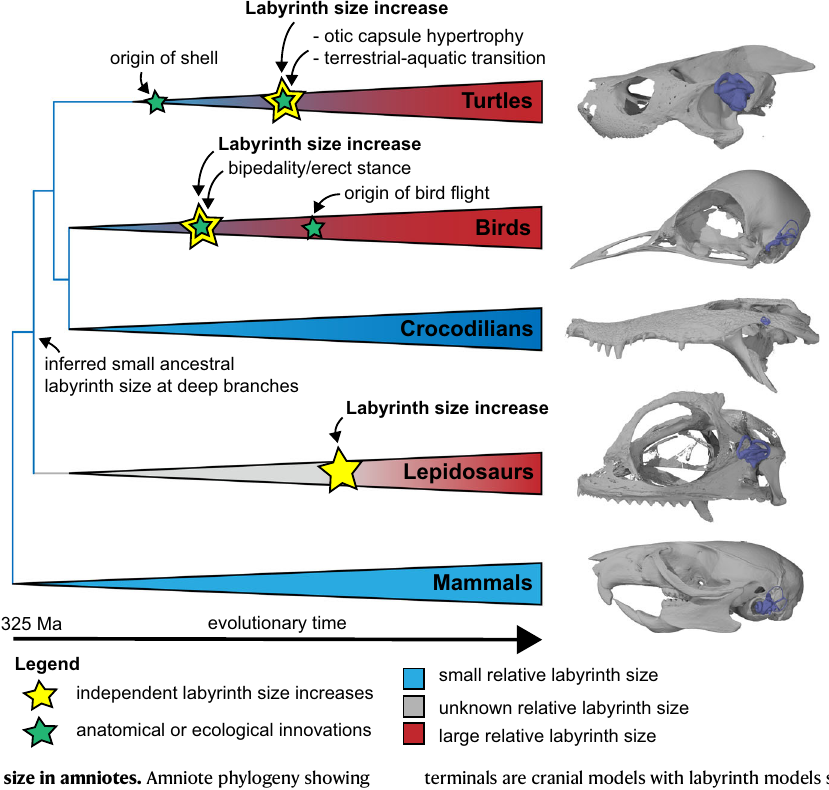
terminals are cranial models with labyrinth models superimposed to illustrate relative labyrinth size, from top to bottom: Dermatemys mawii (SMF 564639); Menura novaehollandiae (FMNH 336751); Crocodylus sp. (BRSUG 28959); Lyr- iocephalusscutatus (OUMNH1298); Acomyscahirinus (NHMUK65.789.793). “ Ma ” is “ million years before present ”